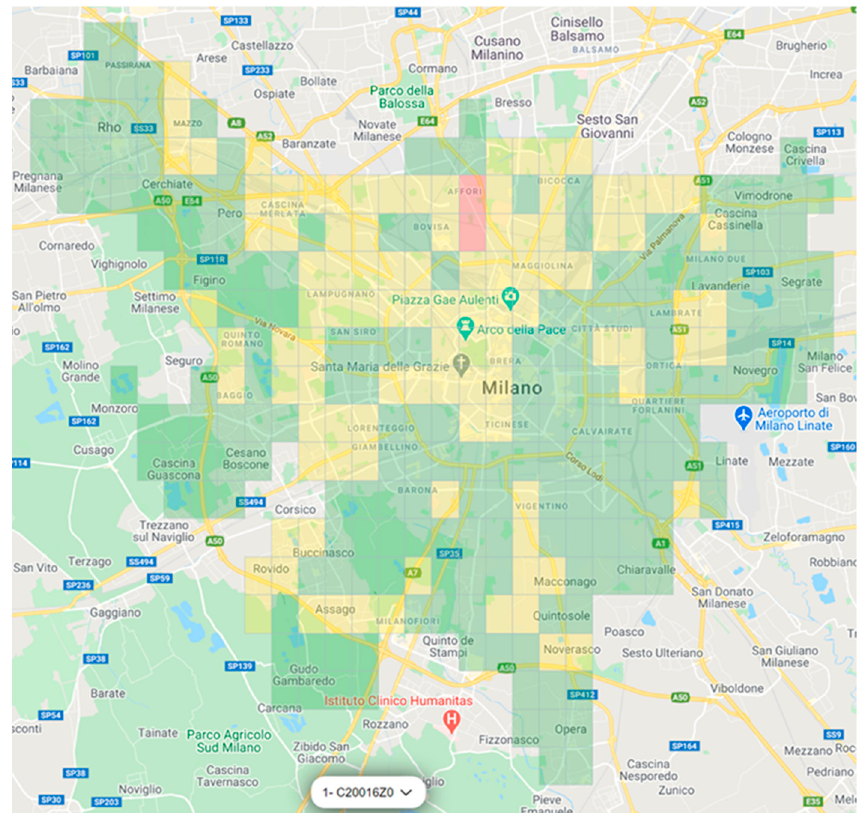
Figure 17. Particulate matter (PM)10 daily average concentrations measured in Milan, retrieved from the blockchain. the